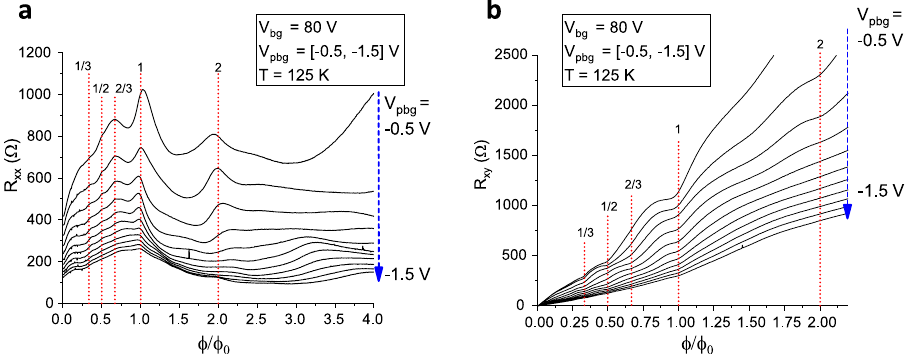
Fig. 3 Brown – Zak oscillations at different carrier densities. Longitudinal resistance R xx ( a ) and transverse resistance R xy ( b ) as a function of magnetic fl ux per superlattice unit cell area ϕ / ϕ 0 for different patterned bottom gate voltages V pbg = − 0.5 V … − 1.5 V at a back gate voltage of V bg = 80 V. At rational fractions of the magnetic fl ux quantum, clear resistance peaks in R xx are visible accompanied by dips in the transverse resistance with the most pronounced feature at ϕ / ϕ 0 =